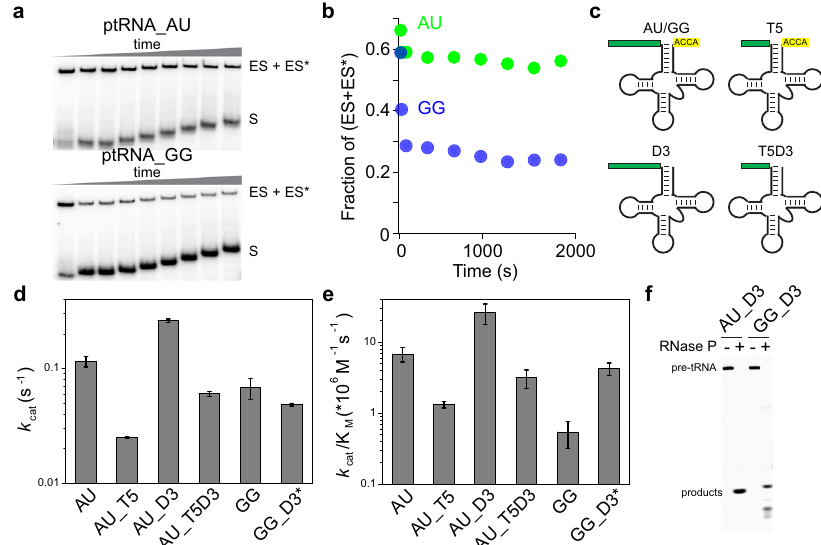
Fig. 3 | Pairing interactions with 3 ′ RCCA limit formation of ES*. a Analysis of ptRNA_AU and ptRNA_GG dissociation kinetics. 5 ′ 32 P-labeled ptRNA_AU (top) and ptRNA_GG (bottom) was bound to 150nM RNase P in 5mM Ca 2+ and then the complexes were challenged with an excess (500nM) of non-radiolabeled ptRNA_GG.ThedissociationofptRNAfromES/ES*wasquanti fi edbynativeEMSAin three independent experiments with essentially identical results. b Quanti fi cation of ptRNA remaining in stable ES* complexes fraction. c Schematic of different ptRNA substrate constructs used to examine the effect of 5 ′ leader length and 3 ′